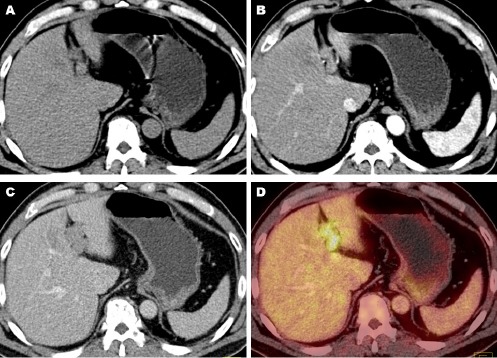
The contrast-enhanced FDG PET/CT shows the tumor thrombosis within the left expansile portal vein. The thrombus appeared isodense in the non-enhanced CT image (A), homogeneously contrast-enhanced in the arterial phase CT (B), and washed out in the portal venous phase CT (C). It showed an increased FDG uptake in the PET/CT image (D)